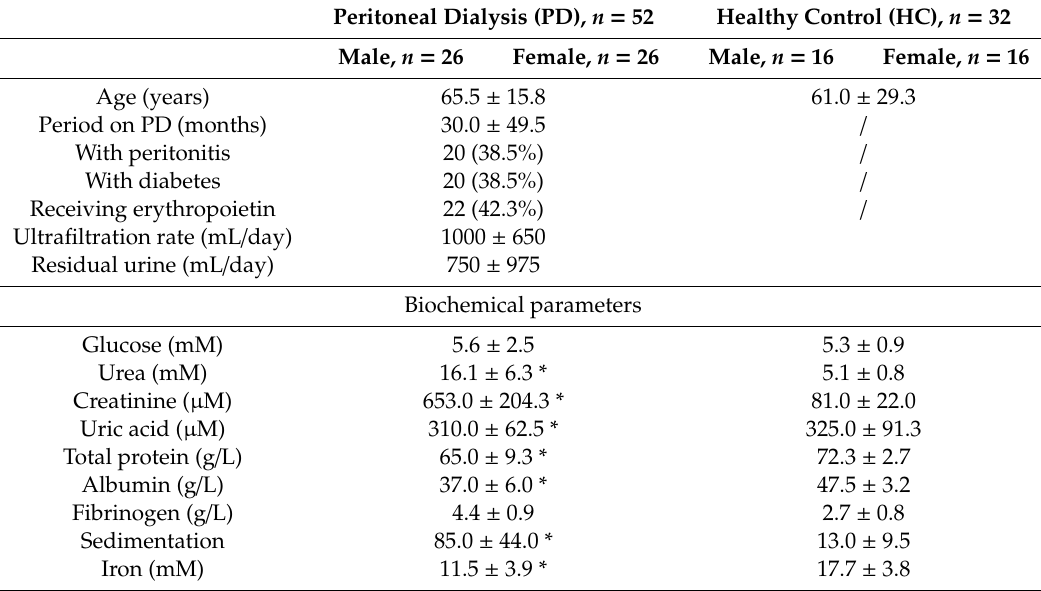
Table 1. Clinical and biochemical characteristics of end-stage renal disease (ESRD) patients on peritoneal dialysis (PD) and healthy control persons (HC). Data are presented as the median ± interquartile range. The statistically significant di ff erence between the groups ( p < 0.05) is labelled with “*”.